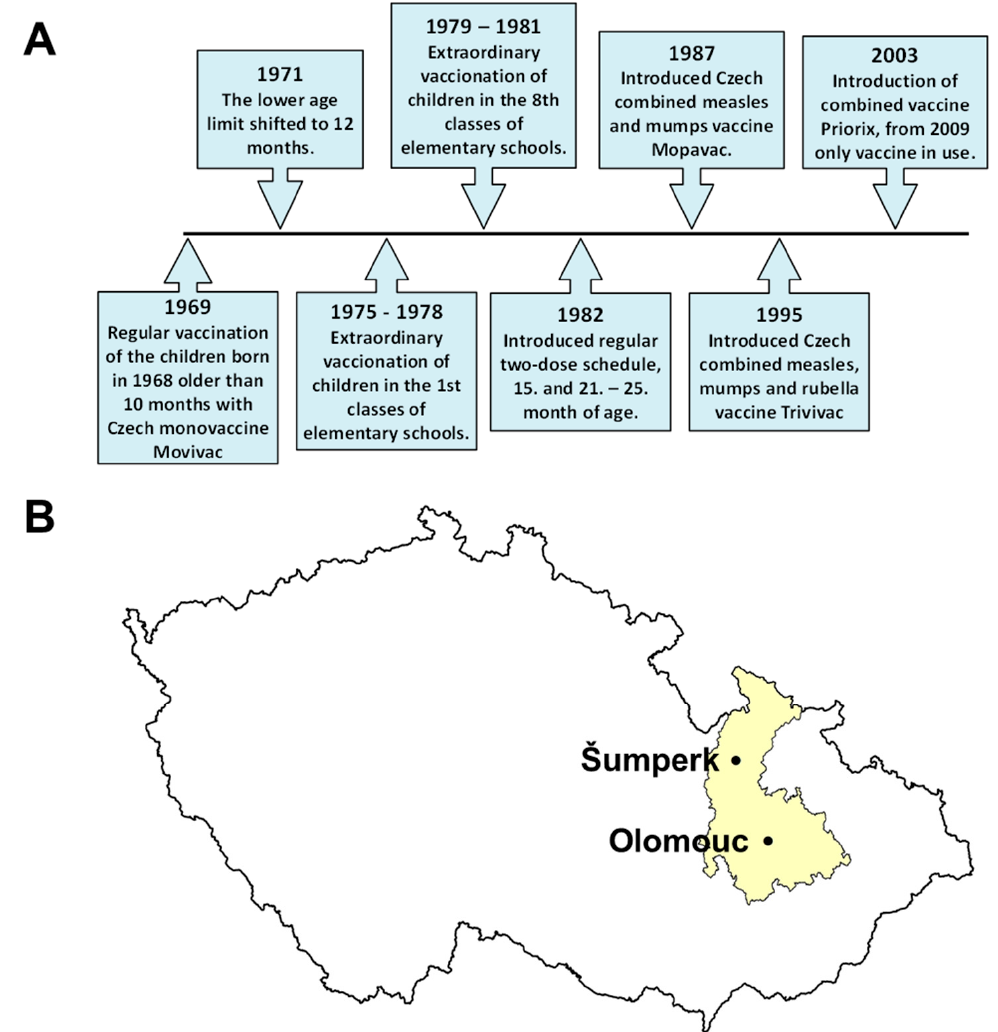
Figure 1. ( A ) Timeline of measles vaccination development in the Czech Republic. ( B ) Map of the Czech Republic with the marked Olomouc region (yellow) and the cities where the laboratories that provided the results for the study are located.